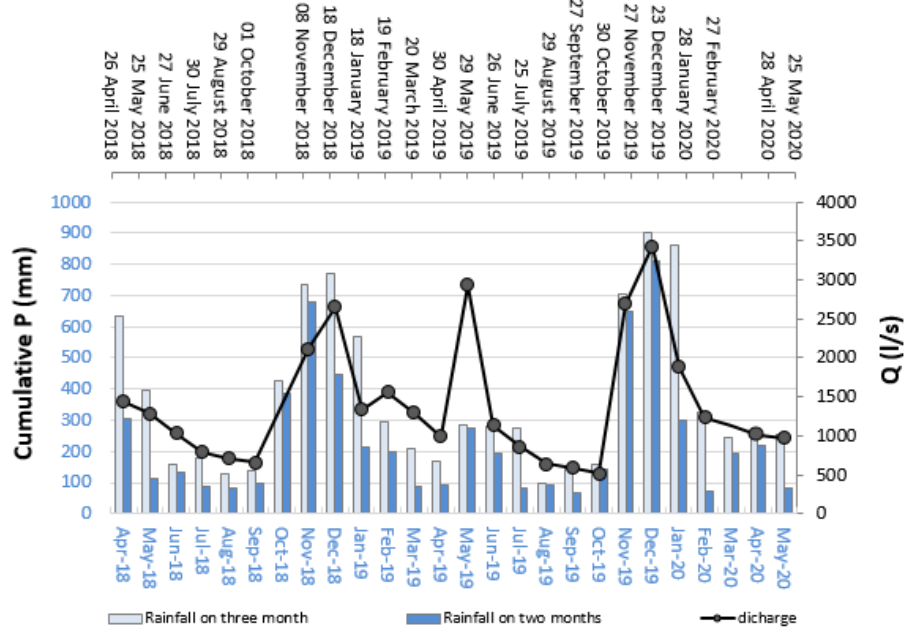
Figure 11. Comparison between spring discharge values (Q) and monthly cumulative rainfall data (Esperia Pluviometric Station, 302 m a.s.l.). Above the graph are the discharge sampling dates.